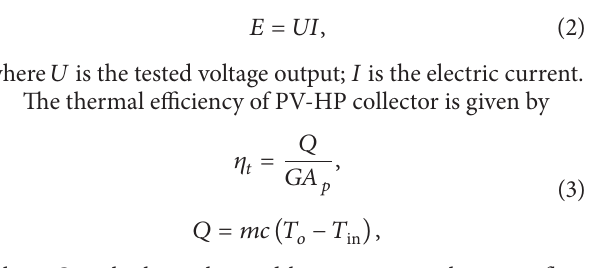
Figure 2: Cross-sectional view of part PV-HP collector.